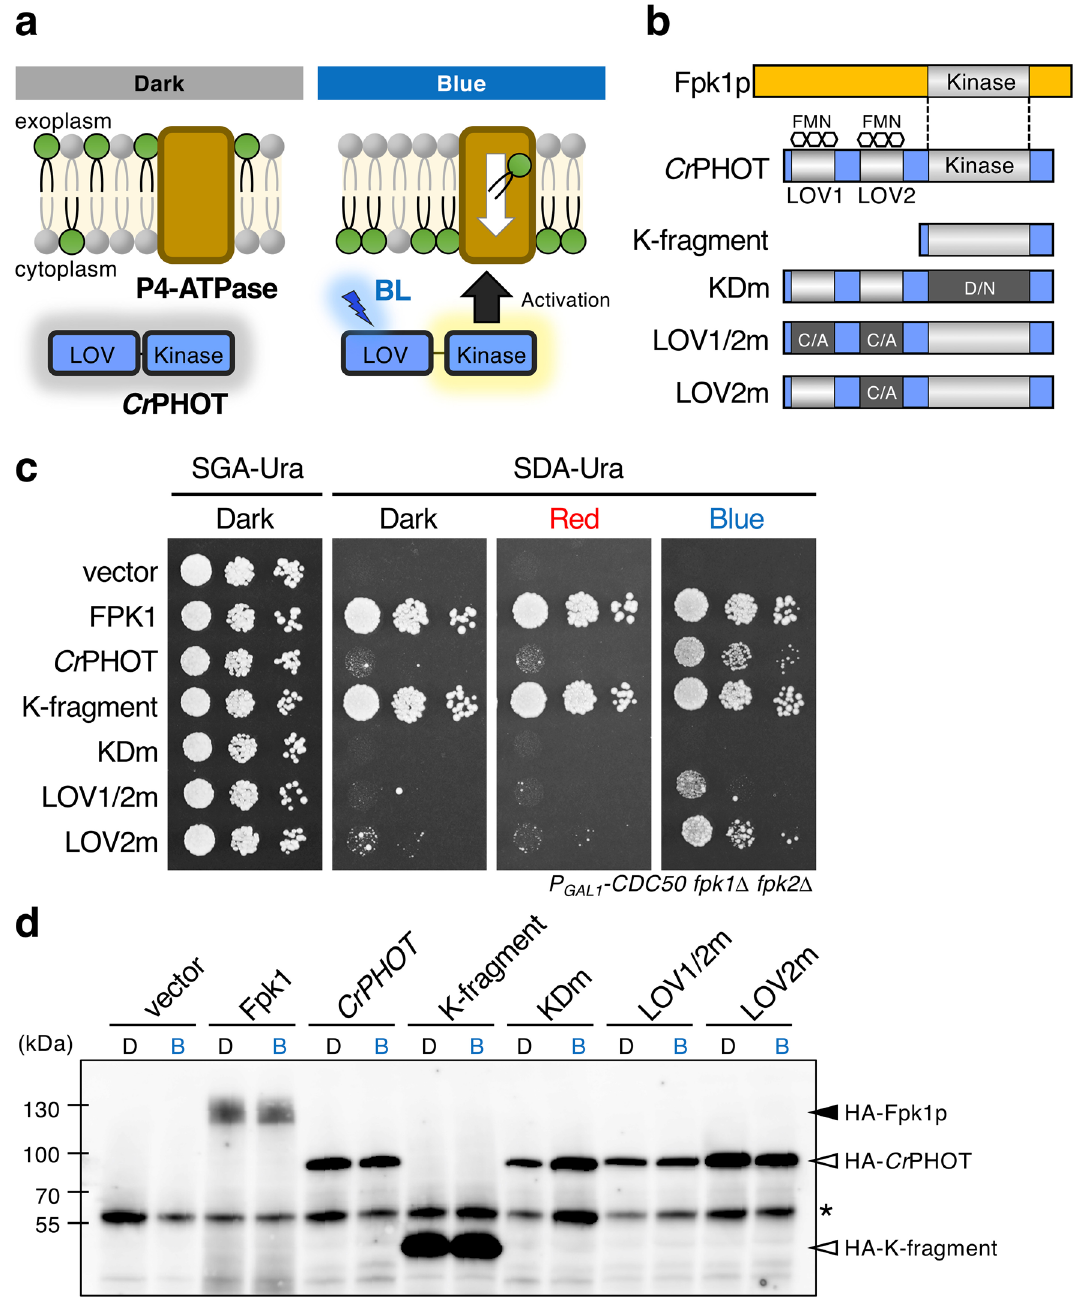
Figure 1. Light control of yeast cell growth by Cr PHOT. ( a ) A schematic of BL-induced activation of flippases through Cr PHOT in yeast. ( b ) Schematic illustration of Fpk1p and Cr PHOT and its derivatives. K-fragment, kinase domain fragment; KDm, kinase-dead mutant with D549N; LOV1/2 m and LOV2m, mutants with a decreased extent of light activation by substitution of conserved Cys in LOV1 and LOV2 domain or LOV2 domain only, respectively, to Ala. Flavin mononucleotide (FMN) is a chromophore of phototropin. ( c ) Growth of the yeast conditional mutant P GAL1 -CDC50 fpk1 Δ fpk2 Δ carrying pRS416- Cr PHOT or its derivatives. Yeast cells were serially diluted and spotted onto plates containing galactose (SGA-Ura) or glucose (SDA-Ura), which were incubated in darkness (Dark) or under 10 μmol m −2 s −1 RL (Red) or BL (Blue) irradiation at 28 °C for 3 days. The experiments were performed more than three times with different biological samples. A representative image is shown in ( c ). ( d ) The protein level of Cr PHOT and its derivatives is not affected by light conditions. HA-fused Fpk1p and Cr PHOT and its derivatives were extracted from the yeast transformants (same strains shown in c ) cultured in darkness ( d ) or under 10 μmol m −2 s −1 BL irradiation ( b ) at 28 °C for 16 h, which were then resolved by SDS-PAGE and analysed by immunoblotting with anti-HA antibodies. Asterisk indicates non-specific